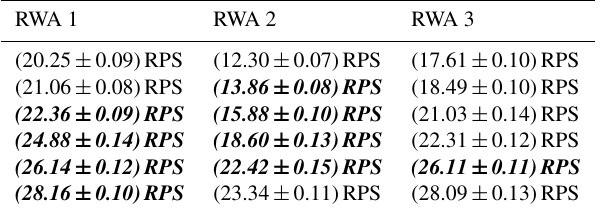
Figure 7. (a) Orientation of the four reaction wheels with respect to the spacecraft body. (b) Alignment of the reaction wheel spin axes with respect to the spacecraft body. The axes of the four wheels are oriented such that | α | = | β | = | γ | = 54 . 74 ◦ . Table 2. Critical wheel speeds for the analyzed period between 13 and 20 May 2019 (FM-A period), as derived from the correlation with the frequency stability depicted in Fig. 8a. The values represent the center frequency and 1 /e 2 width from Gaussian fits applied to the six most pronounced peaks. The strongest peaks for each reac- tion wheel are indicated in bold type, while those frequencies which are critical for both lasers are additionally printed in italics.